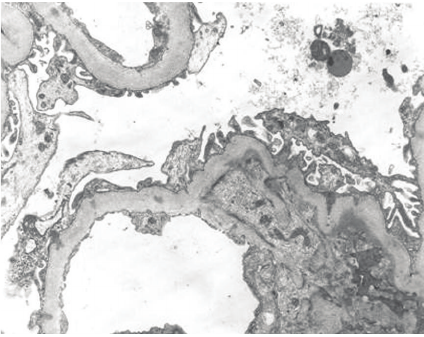
Figure 2: Electron microscopy performed in a patient with C1q nephropathy confirming immunofluorescence findings as mesan- gial electron dense deposits. In addition, diffuse podocyte foot processes effacement is also identified, indicating podocyte